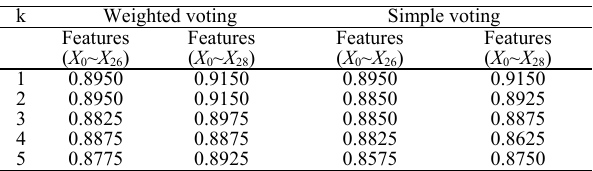
Table 3. Recognition accuracy for the k-NN classifiers